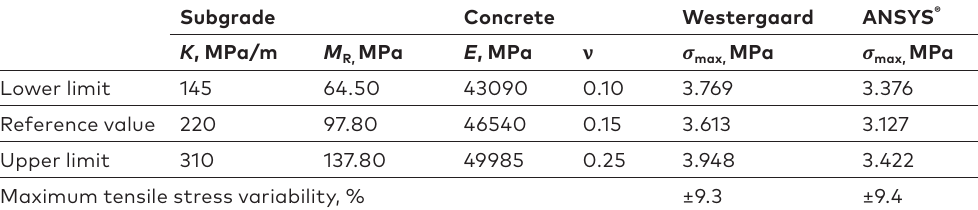
Table 1. Maximum variability of maximum tensile stress